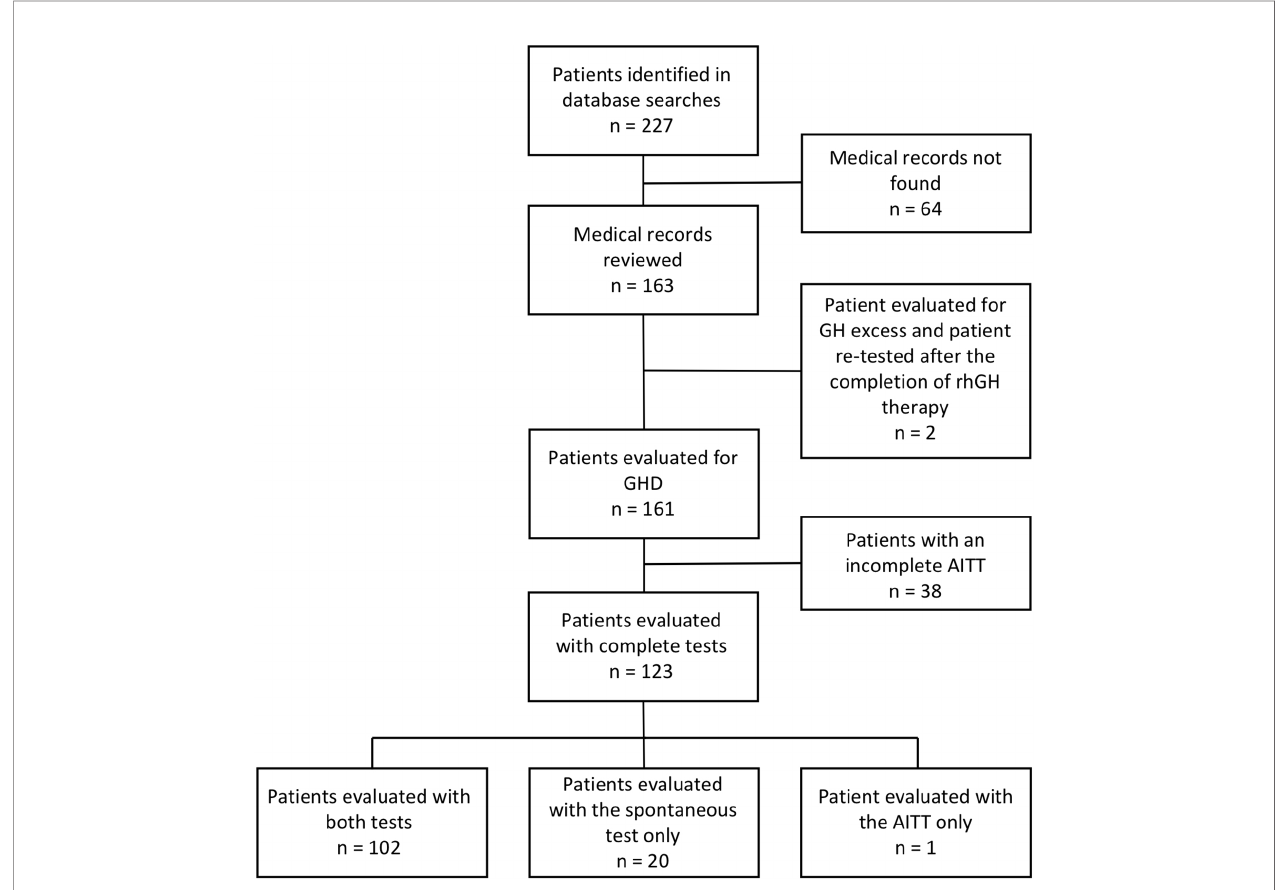
FIGURE 1 | Flowchart of included and excluded children with short stature evaluated for possible GHD. AITT, arginine-insulin tolerance test. GH, growth hormone. GHD, growth hormone de fi